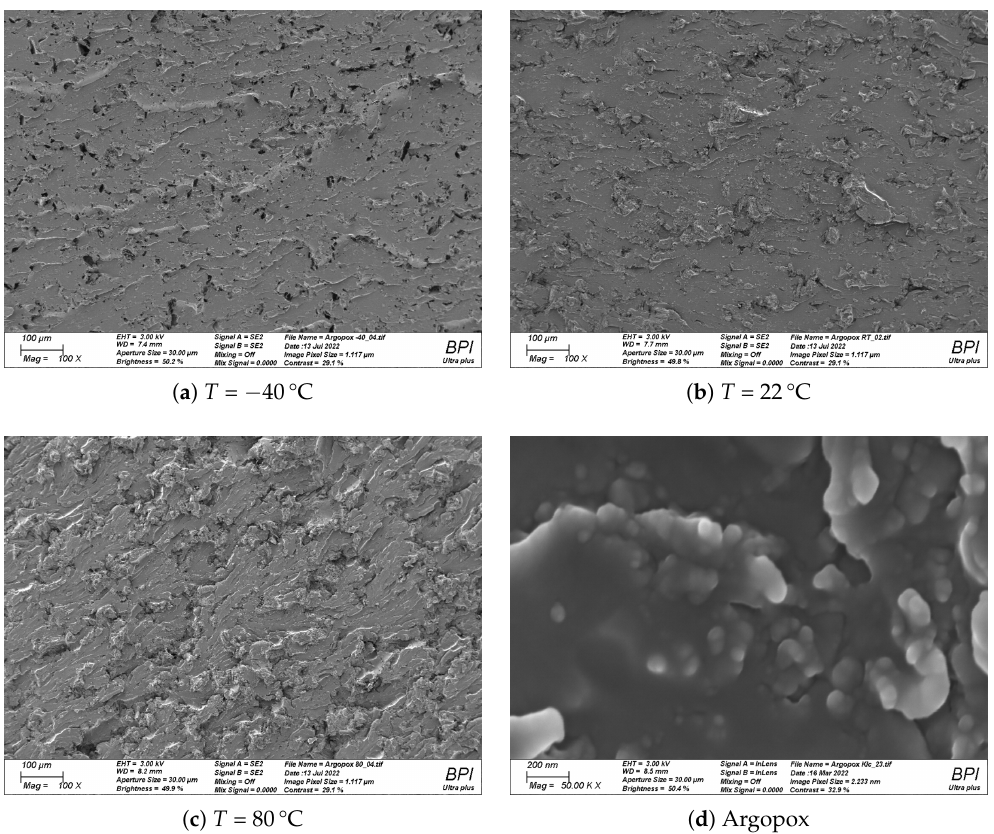
Figure 7. Fracture surfaces of compact tension specimens made from Argopox after testing at T = − 40°C ( a ), 22°C ( b ), and 80°C ( c ). Scanning electron microscopy image of cured Argopox at 50,000 × magnification showing the nanometer-sized L -arginine particles ( d )